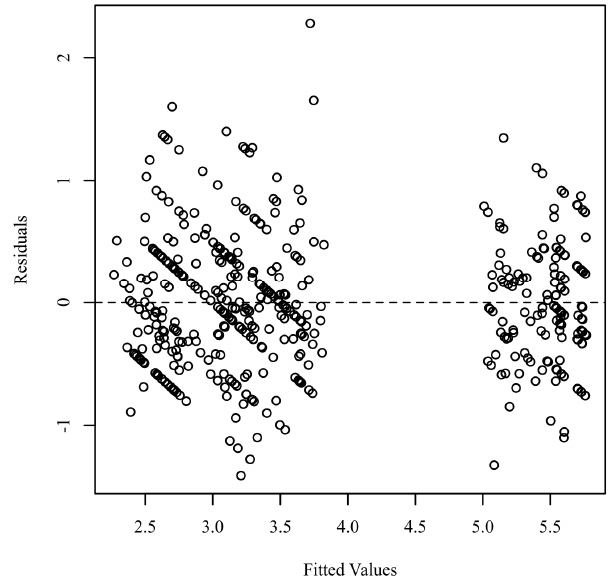
Figure 4. Residuals scatterplot testing homoscedasticity.